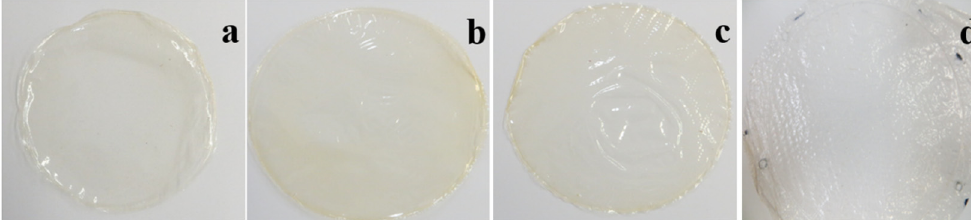
Figure 1. Photographs of chitosan films obtained from low molecular ( a ), medium molecular ( b ), low molecular weight ( c ) and Brachystola magna chitosan films ( d ).